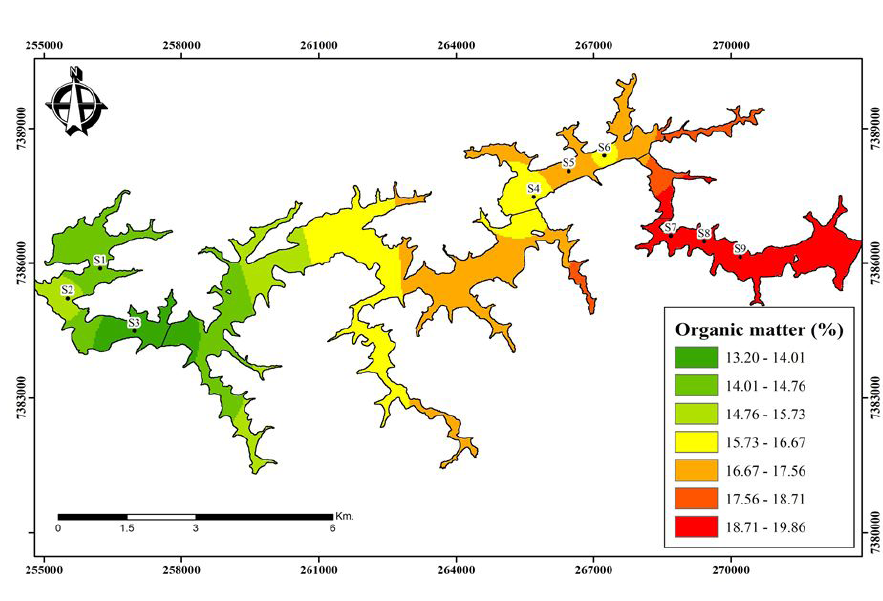
Figure 3. Map of the organic matter (OM, %) distribution. The colors of the map represent the percentage of organic matter found along the reservoir, according to the organic matter amount assessed. The areas where no sampling collection occurred were filled according to the interpolation of data applied through